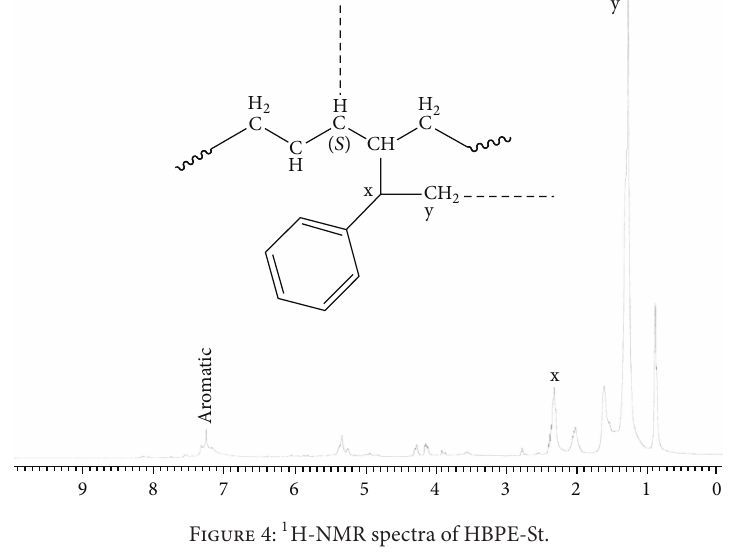
Figure 4: 1 H-NMR spectra of HBPE-St.